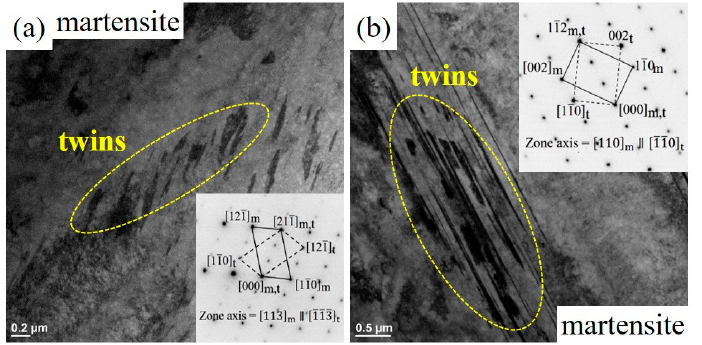
Figure 6. Microtwin images of ( a ) water- and ( b ) liquid N2-quenched solid solution specimens, along with their diffraction patterns in the bottom-right corner ( a ) and top-right corner ( b ).